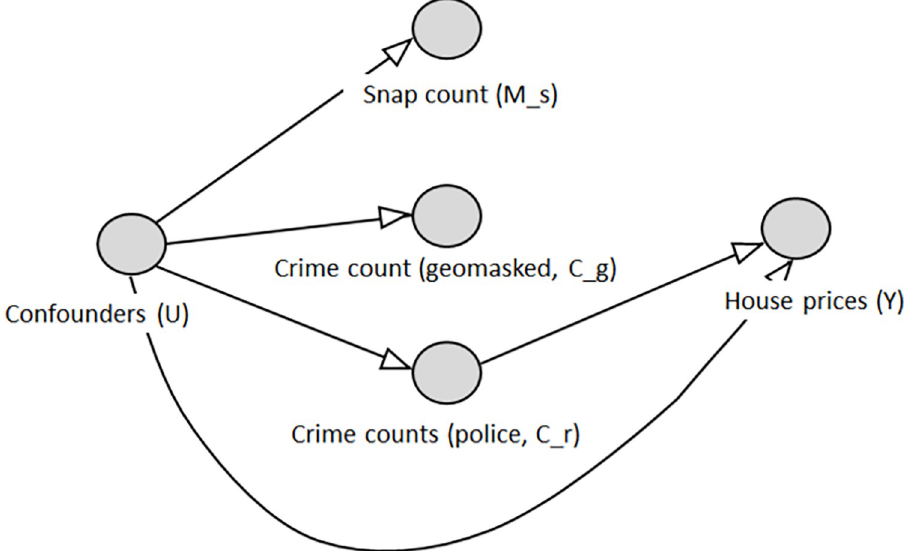
Fig 2. DAG/ path diagram of causal relations. We assume the existence of police.uk only affected house prices through i) the information shown on the website (modifying C g ! Y ) and ii) changing the relationship between ! Y ). Other causal relationships are unchanged, and information outside the website and house prices ( U ! Y , U ! C r this forms the basis for our assumption tests later.